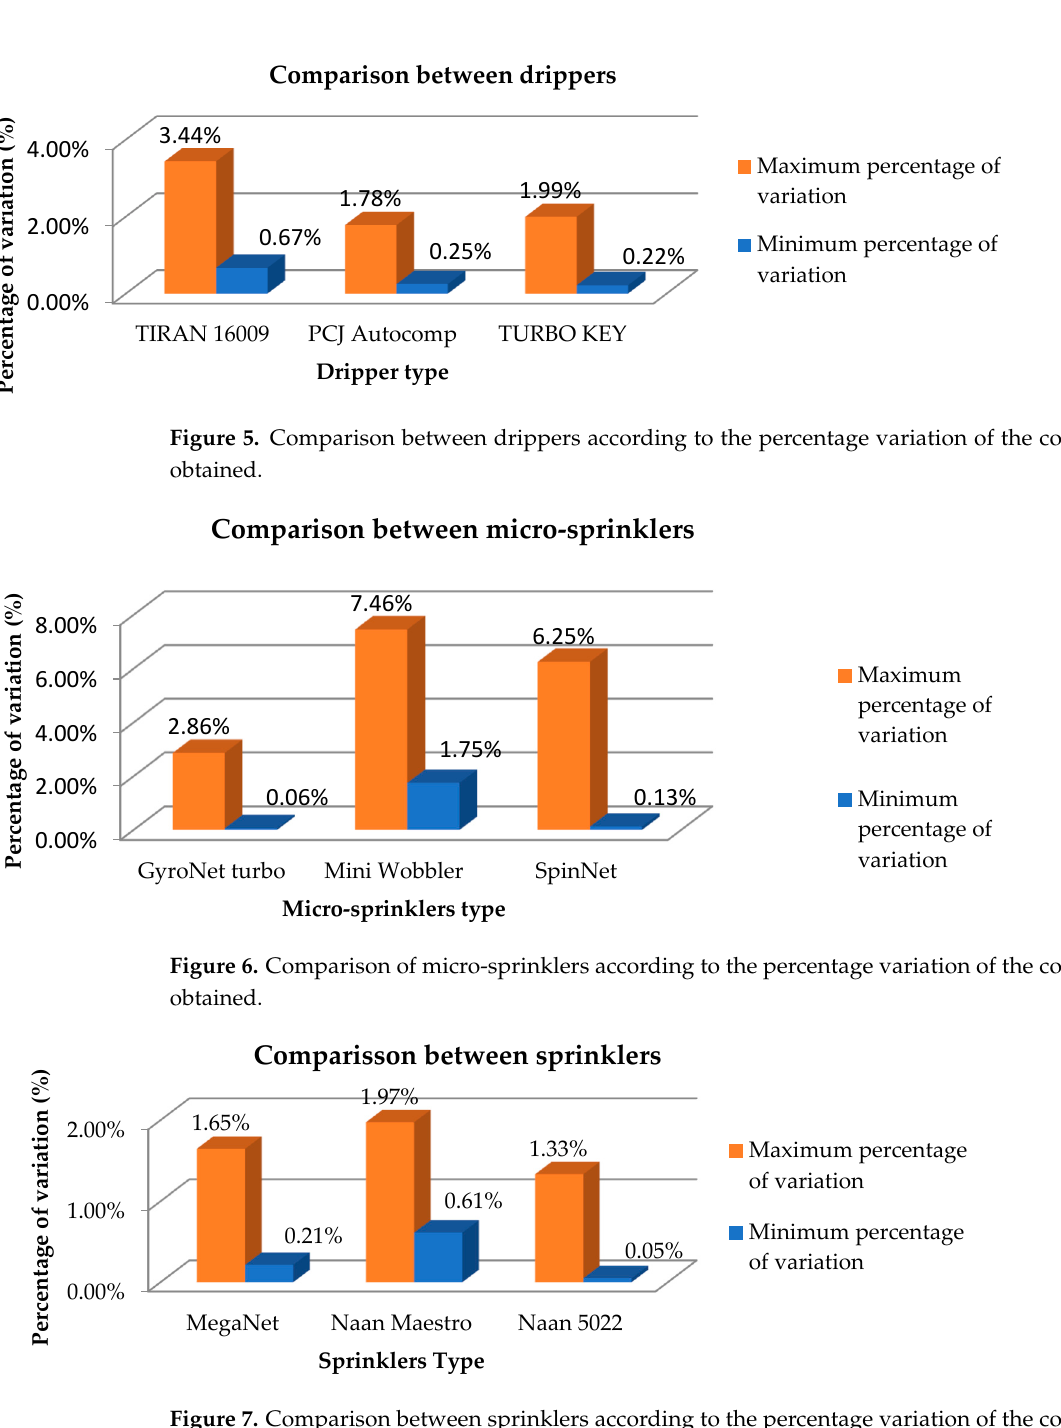
Figure 7. Comparison between sprinklers according to the percentage variation of the coefficients obtained. Table 3. Comparison of field measured and modelled discharge flow rates in Epanet 2.0 micro- sprinklers.